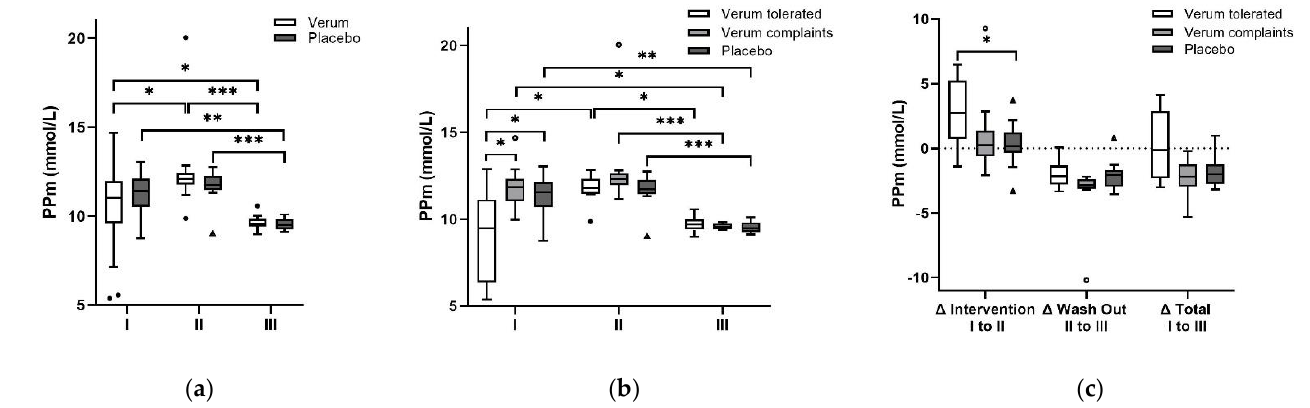
Figure 2. Progression of total plasma polyphenol microtiter (PPm) concentrations over the three investigation time points: ( a ) PPm increased significantly between baseline (I) and after the intervention (II) in the whole verum (V) group ( p = 0.040); however, the significance did not remain after Bonferroni correction ( p = 0.119) and PPm of the placebo (P) group did not change during the intervention. PPm decreased in both groups over time. ( b ) The separation of V into participants who tolerated the juice (Vt) compared to those who reported complaints (Vc) revealed significantly lower PPm in Vt at I ( p = 0.010). PPm in Vt increased significantly from I to II ( p = 0.024) whereas the PPm plasma concentrations of Vc and P remained constant. After Bonferroni correction, the increase in Vt did not remain significant. ( c ) The absolute difference of plasma PPm between the measurement time points (Δ) was the highest in Vt from I to II whereas PPm almost remained stable in Vc and P. The absolute increase in Vt was significantly higher compared to P ( p = 0.015) and at least a trend towards significance was observed compared to Vc ( p = 0.051). A decrease in PPm plasma concentrations was observed in all three groups during the washout phase. In Vt PPm almost returned to baseline concentrations after the washout period. p -values < 0.05 are marked with *, < 0.01 with **, and < 0.001 with ***. Outlayers of V and Vt are highlighted as black circles, of Vc as circles, and of P as black triangles. Abbreviations: V: verum, Vt: verum tolerated, Vc: Verum complaints, P: placebo, PPm: polyphenol microtiter, I: baseline, II: after intervention, III: after washout, Δ: difference between two measurement points.